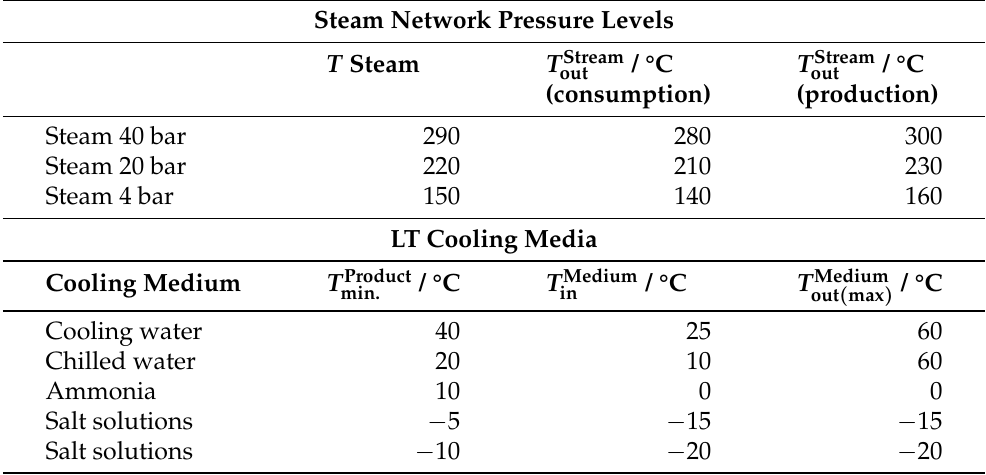
Table 2. First part: Pressure stages and temperatures of the employed steam network; second part: Temperatures of the cooling media and the process